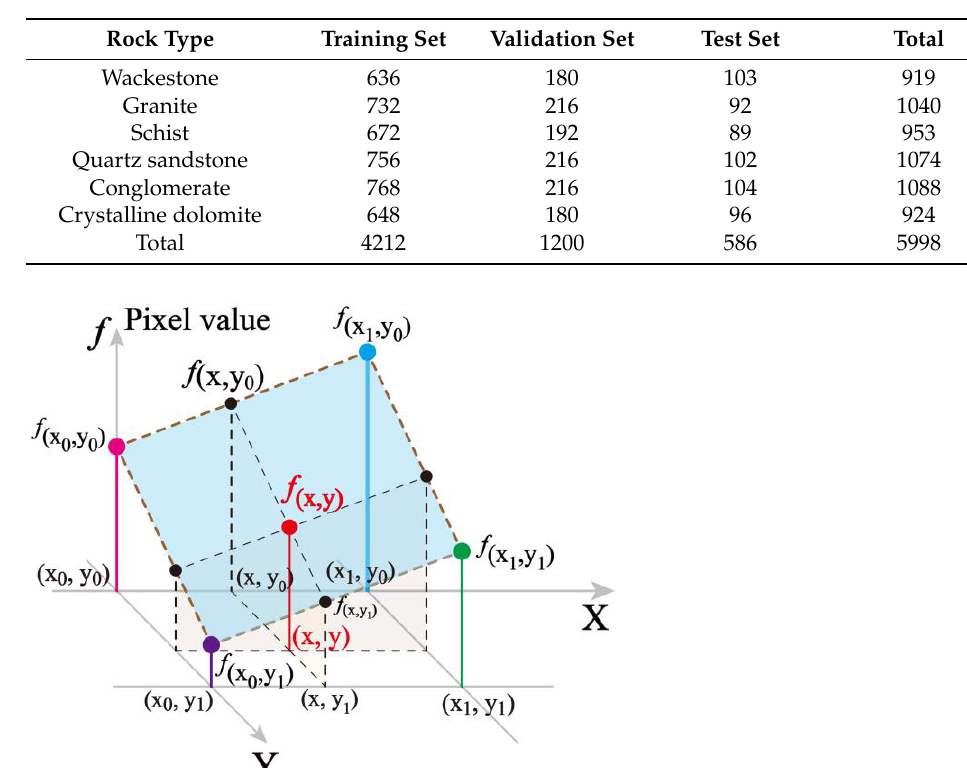
Table 1. Rock thin section image set.